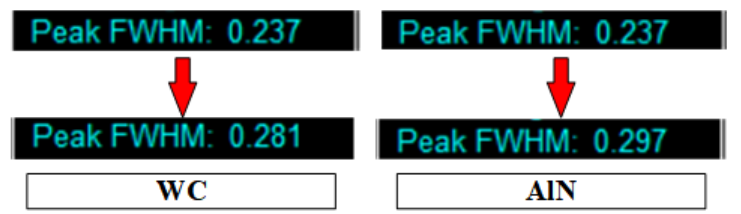
Figure 8. The half width and height of WC and AlN peaks change after adding Cr element.